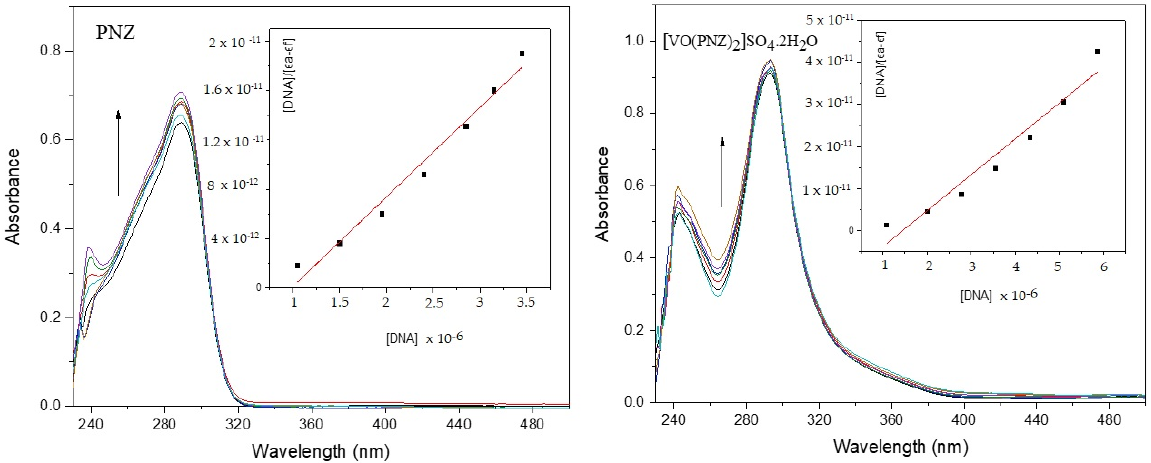
Figure 8. Absorption spectra of PNZ and its complex in the presence of increasing DNA concentra-